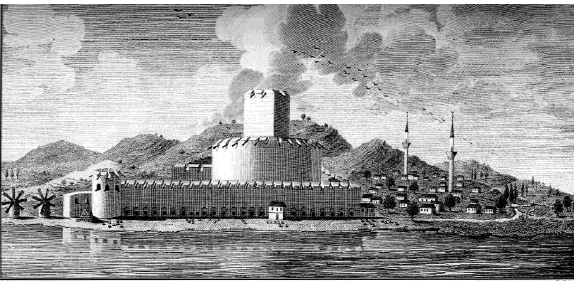
Figure 04 : Gravure 03: Joseph Moreno's Gravure dated 1790 (Ministry of Culture and Tourism - Anatolian Gravure Album)